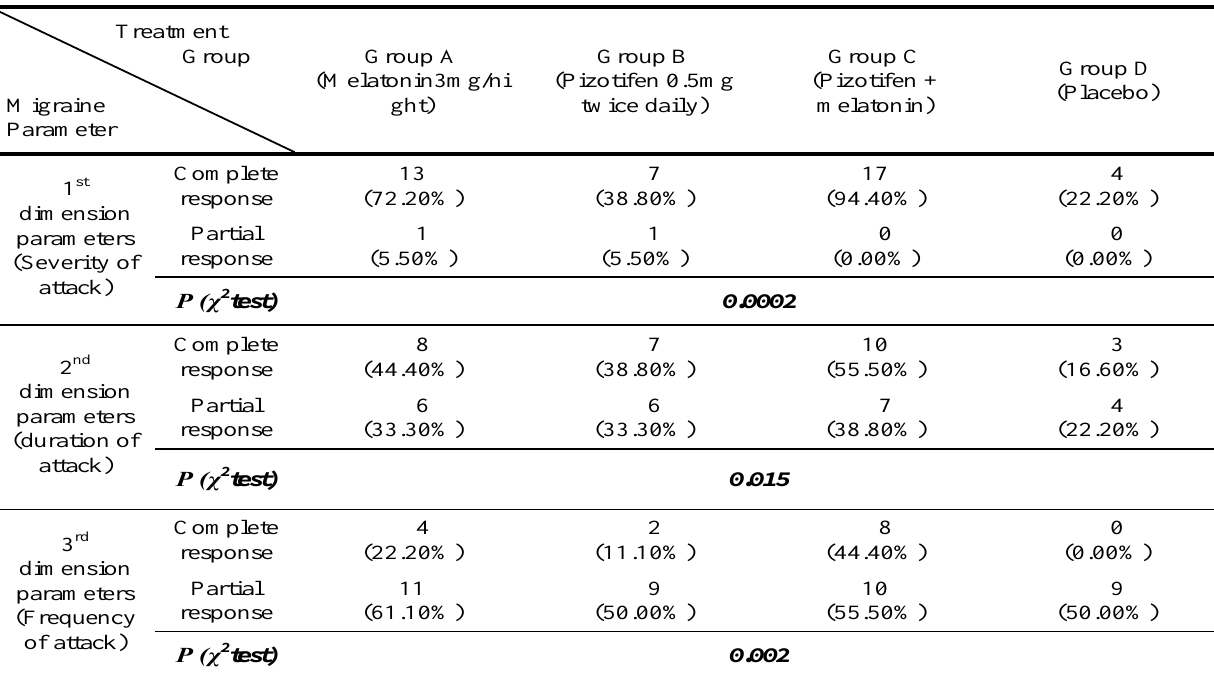
Table (2): Distribution of patient’s response to different medications according to the 1 st , 2 nd and 3 rd dimension parameters of